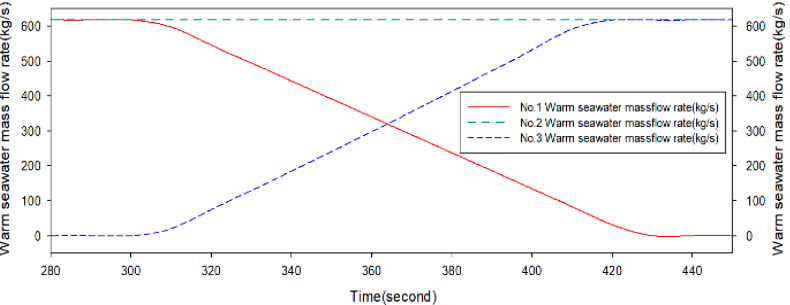
Figure 10. Flow rate gradient of surface seawater pump.